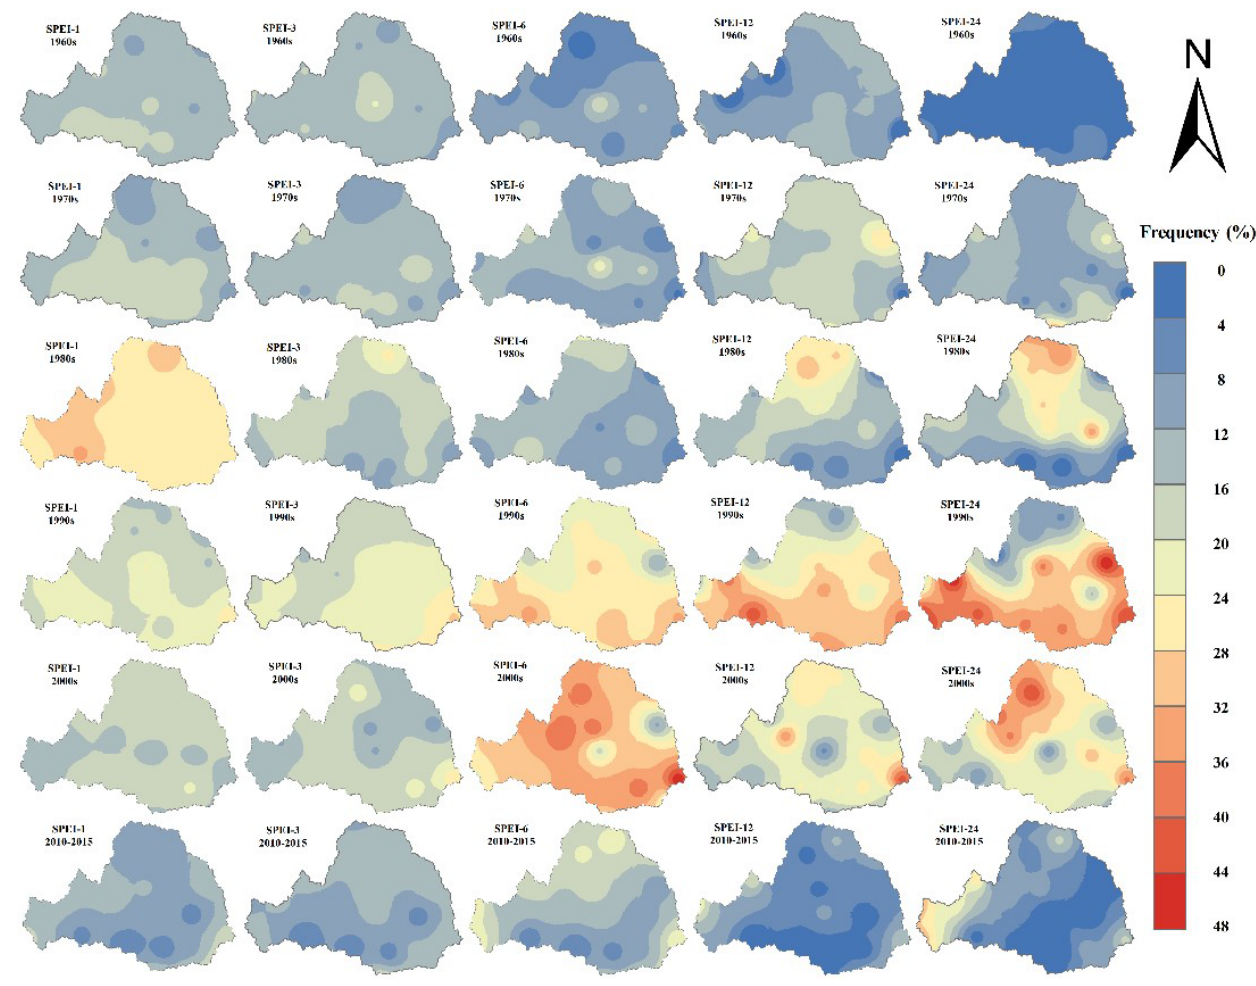
Figure 5. Spatial distributions of drought frequency at various time scales during the six decades in the Wei River Basin.